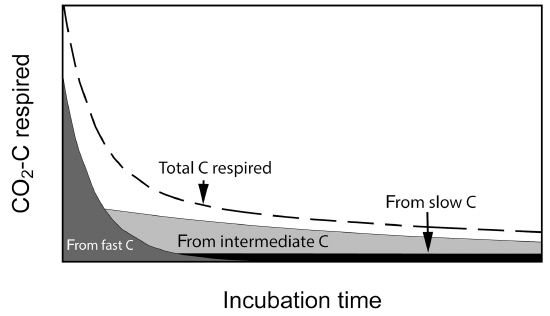
Figure 1. Conceptual figure of C respiration during aerobic soil incubations. Total CO 2 − C flux is composed of contributions from different C pools which changes over time. Fast-cycling C domi- nates total CO 2 − C flux at the beginning of the incubation and is later replaced by slower-cycling C